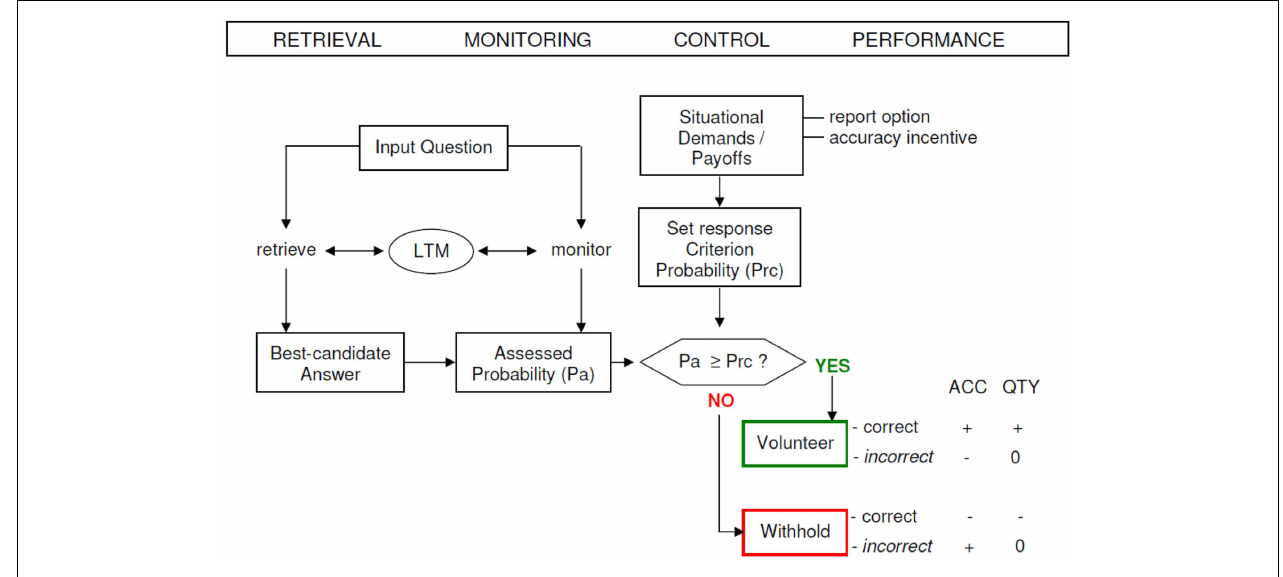
effect). LTM, long-term memory; ACC, accuracy; QTY, quantity; Pa, assessed probability; Prc, response criterion probability (modified from Koriat and Goldsmith,